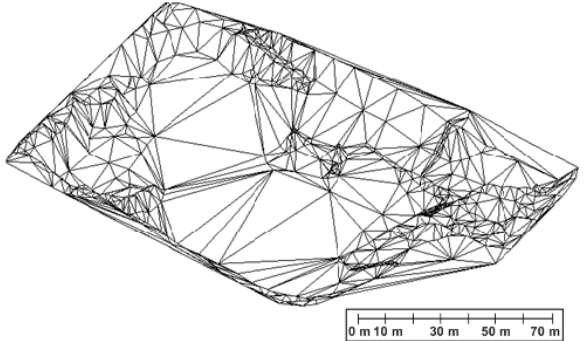
Figure 15. The generated Triangular Irregular Network-Digital Terrain Model (TIN-DTM) used to measure the volume of the excavation.